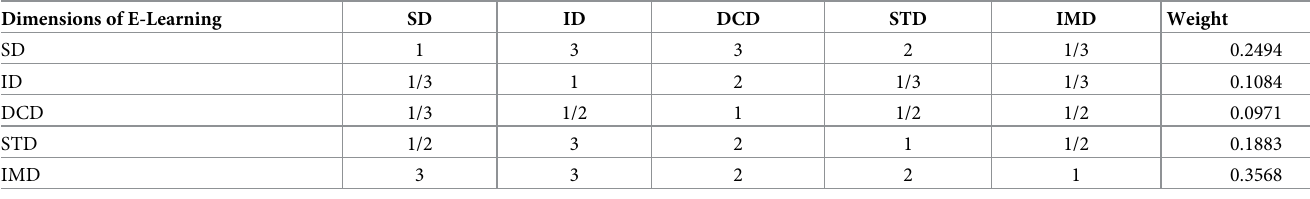
Table 7. A pairwise comparison of E-Learning dimensions by DM5 using AHP-GDM. Dimensions of